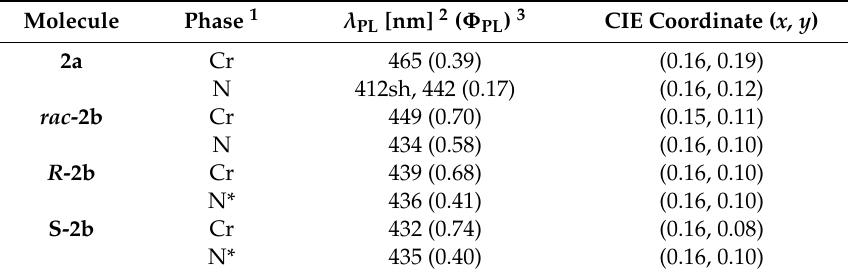
Figure 6. ( a ) Photoluminescence (PL) spectra of 2a , rac - 2b , R - 2b , and S - 2b in the Cr-phase. ( b ) CIE color diagram showing the PL colors of samples in ( a ). Table 4. Photophysical data of 2a , rac - 2b , R - 2b , and S - 2b measured for crystalline and liquid–crystalline phases.